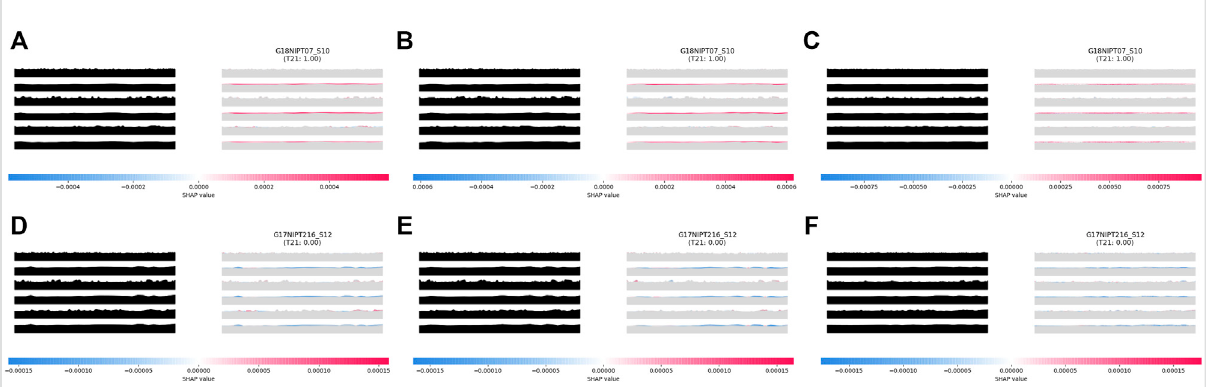
FIGURE 1 Distribution of feature importance for the aiD-NIPT algorithm for trisomy 21. The results of the aiD_IQR (A) , aiD_Mean (B) , and aiD_Median (C) analyses of the positive samples of trisomy 21, and the results of the aiD_IQR (D) , aiD_Mean (E) , and aiD_Median (F) analyses of the normal samples. The red SHapley Additive exPlanations (SHAP) value indicates positive, and the blue SHAP value indicates negative feature importance for the corresponding region. The feature importance on the edge of the TC at the 2nd, 4th, and 6th positions on the target repeat stacking image is showntobehigh,suggestingthatthemodelhaslearnedtoidentifypositiveandnegativesamplesbyanalyzingtheoverallpatternofTC.aiD:arti fi cial intelligence of fragment distance; IQR: interquartile range; NIPT: non-invasive prenatal testing; TC: target